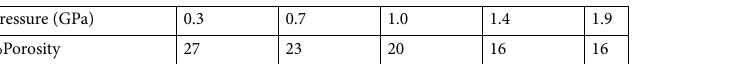
Table 2. The porosity of of (Bi, Pb)-2223 superconductor electrodes manufactured at different pressure.